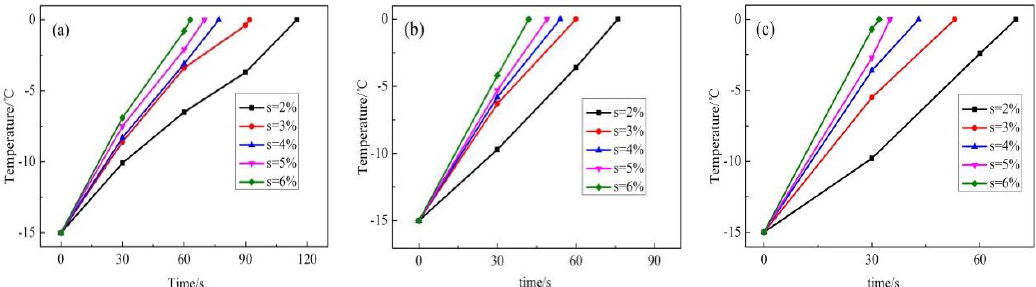
Figure 12. The influence of content and length of steel wool fiber on ice layer temperature. ( a ) 1 mm; ( b ) 3 mm; ( c ) 5 mm.